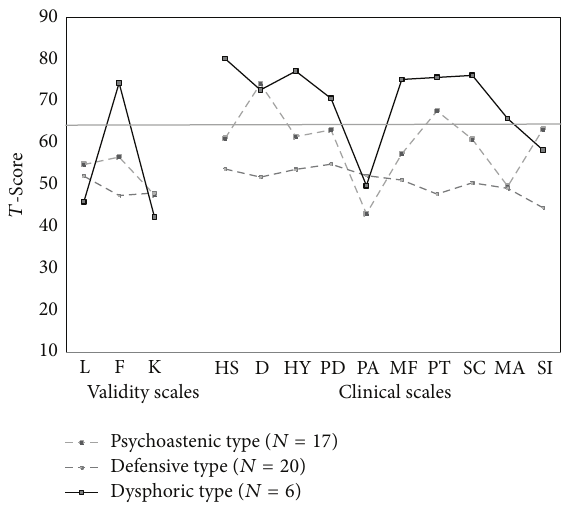
Figure 1: MMPI-2 cluster